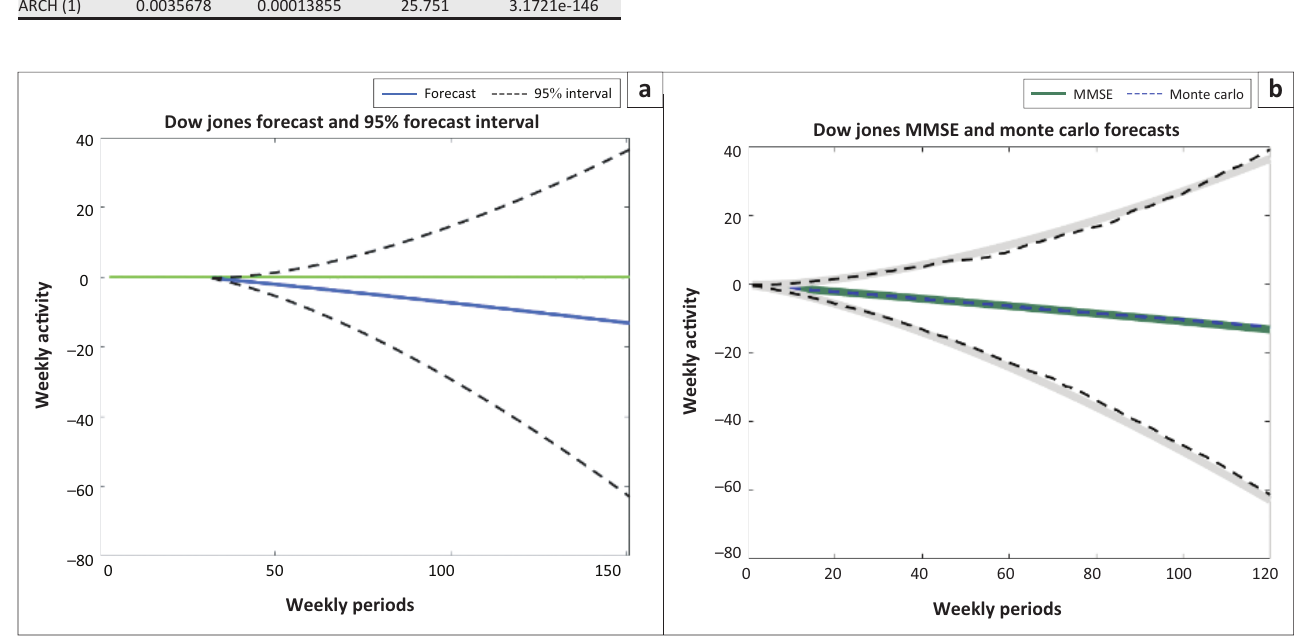
MMSE, Monte Carlo and a minimum mean square